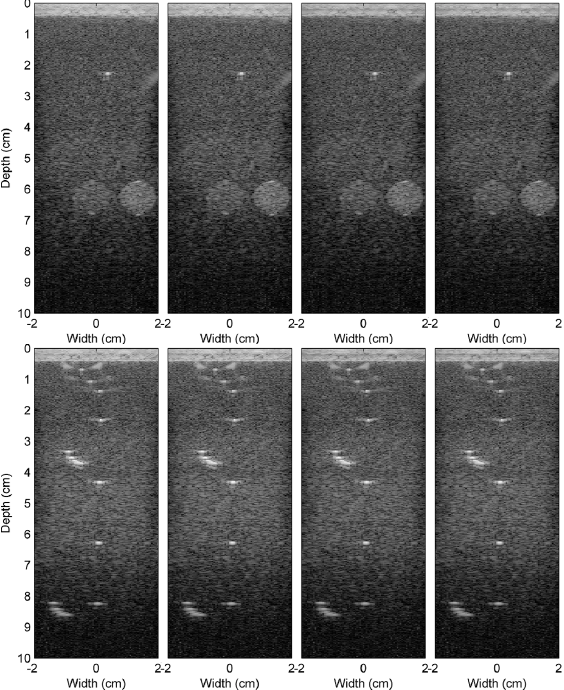
Figure 8. Comparison of the ultrasound images from Experiments 2 (top row) and 3 (bottom row) reconstructed usingfour4 different schemes, C-N-D, C-IQ-D, P-N-D and P-IQ-D, from the left to the right, respectively.